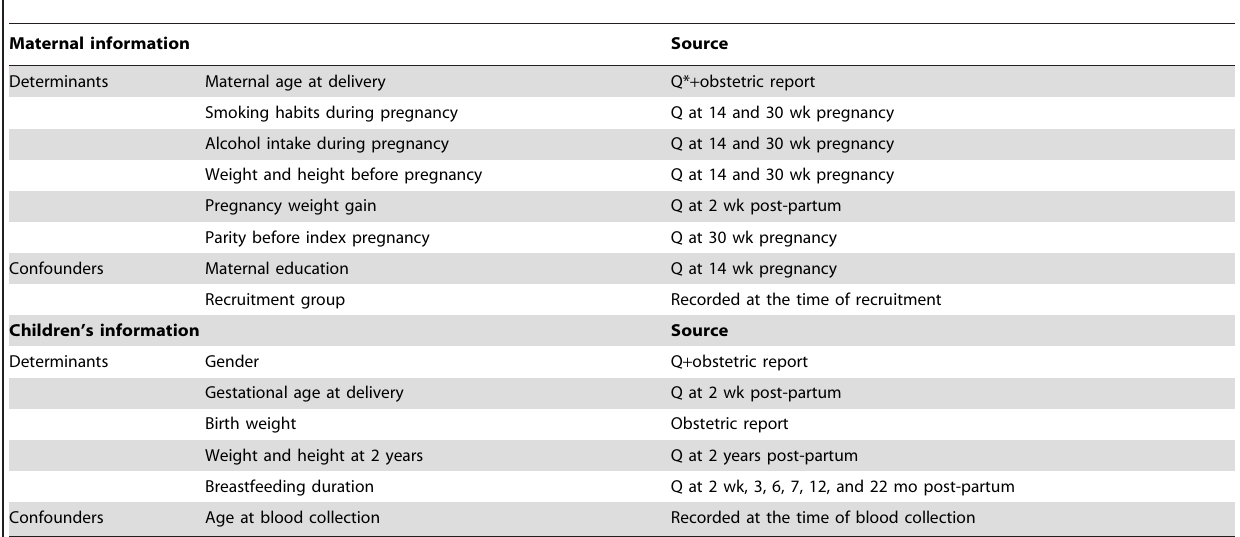
Table 1. Maternal and children’s non-genetic potential determinants of blood lipids, possible confounders, and data source.